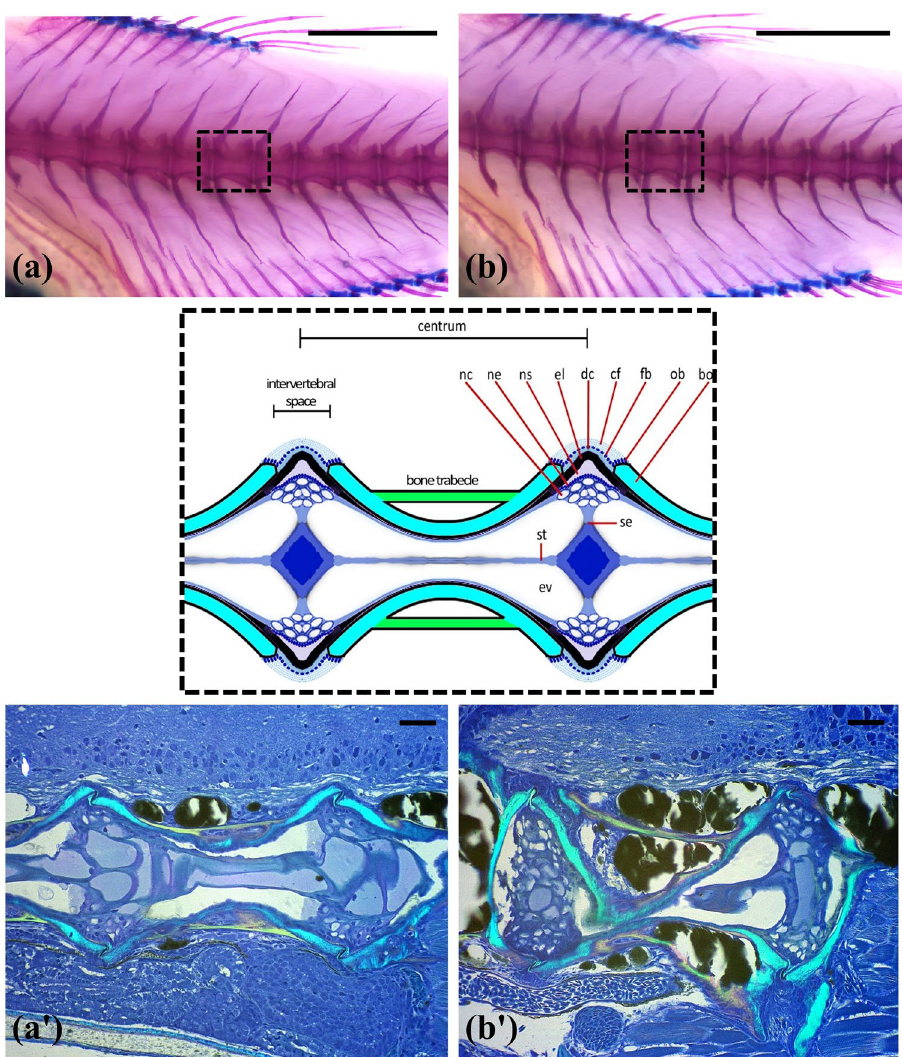
Figure 2. Comparison of a normal (N) ( a , a ′ ) and a recovered fish (s-L/rec) ( b , b ′ ) 4 days post exercise. Stained pictures ( a , b ) and parasagittal sections ( a ′ , b ′ ) of the vertebral bodies located in the center of haemal lordosis. Bo, bone of the vertebral body endplate. Cf, collagen type I fiber bundles. Dc, dense collagen type I matrix. El, elastin. Ev, extracellular vacuole. Fb, fibroblasts. Nc, vacuolated notochord cells. Ne, notochord epithelium. Ns, notochord sheath. Ob, osteoblasts. Se, septum. St, notochord stan. Scale bars equal to 1 mm ( a , b ) and 50 μm ( a ′ , b ′